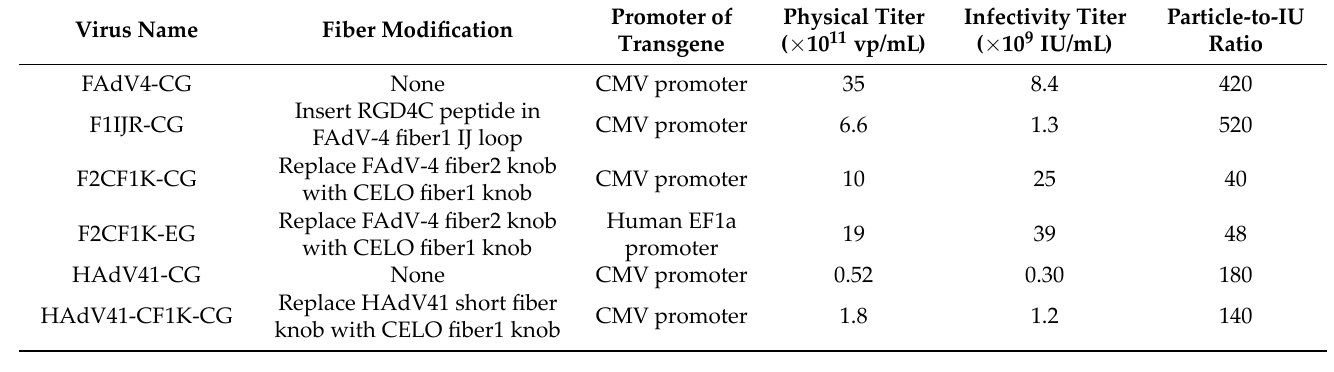
Table 2. Summary information of purified FAdV‑4 and HAdV‑41